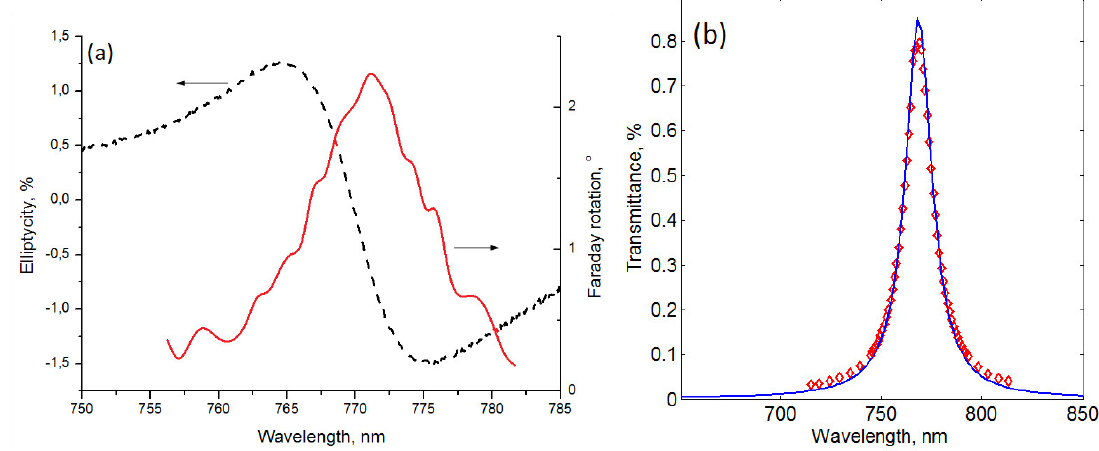
Figure 5. ( a ) Experimental Faraday rotation (solid line) and Faraday ellipticity spectra (dashed line) for the sample-4 with Ag layer on top. ( b ) Transmittance spectra for the sample-4 with Ag layer on top. Solid line is for the calculation and diamonds represent experimental